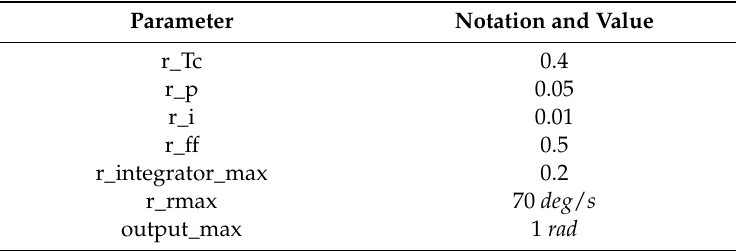
Table A2. Roll angle control system parameters. Table B2. Roll angle control system parameters. Table B2. Roll angle control system parameters.